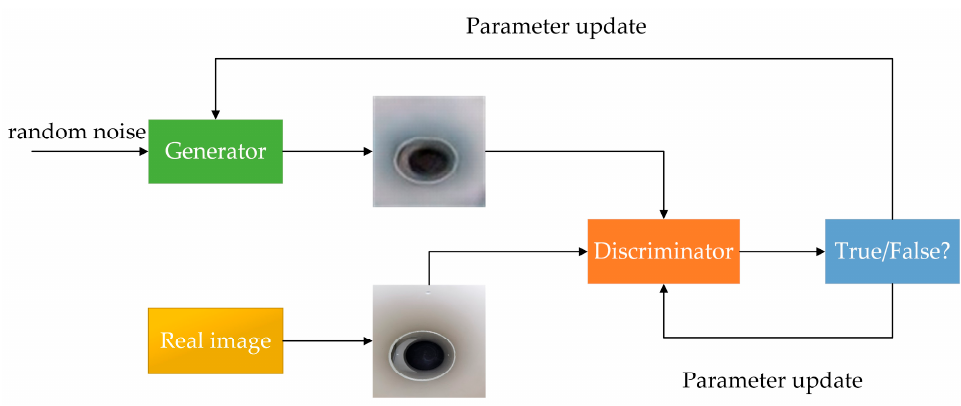
Figure 4. DCGAN structure diagram.